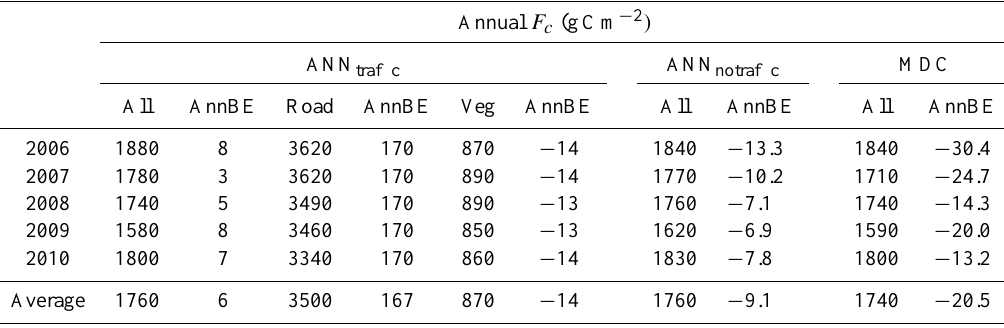
Table 3. The annual CO 2 fluxes (in gCm − 2 ) and biased errors (AnnBE, Eq. 2) with different gap filling methods: artificial neural net- work with and without traffic counts (ANN traffic and ANN notraffic , respectively) and median diurnal cycles (MDC). For ANN traffic , annual emissions are also given separately for the road and vegetation surface areas.